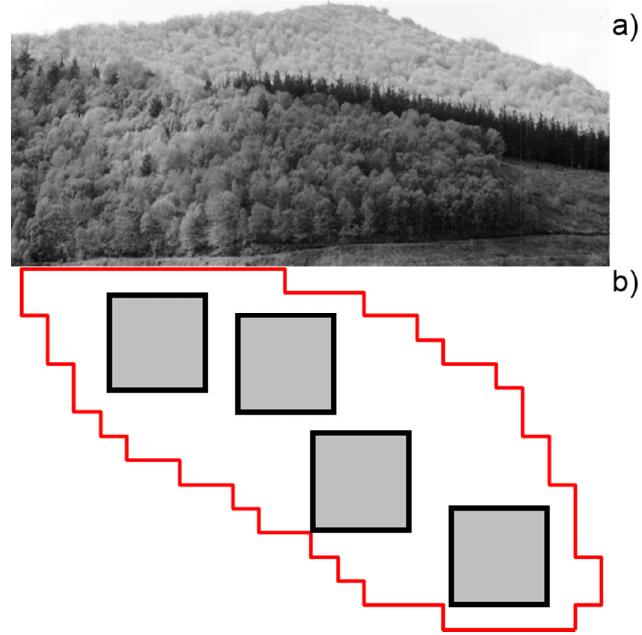
Figure 1. ( a ) View of the study area in northern Spain. ( b ) Experimental design with the spatial distribution of the four sampled 40 m × 40 m plots (6400 m 2 ).